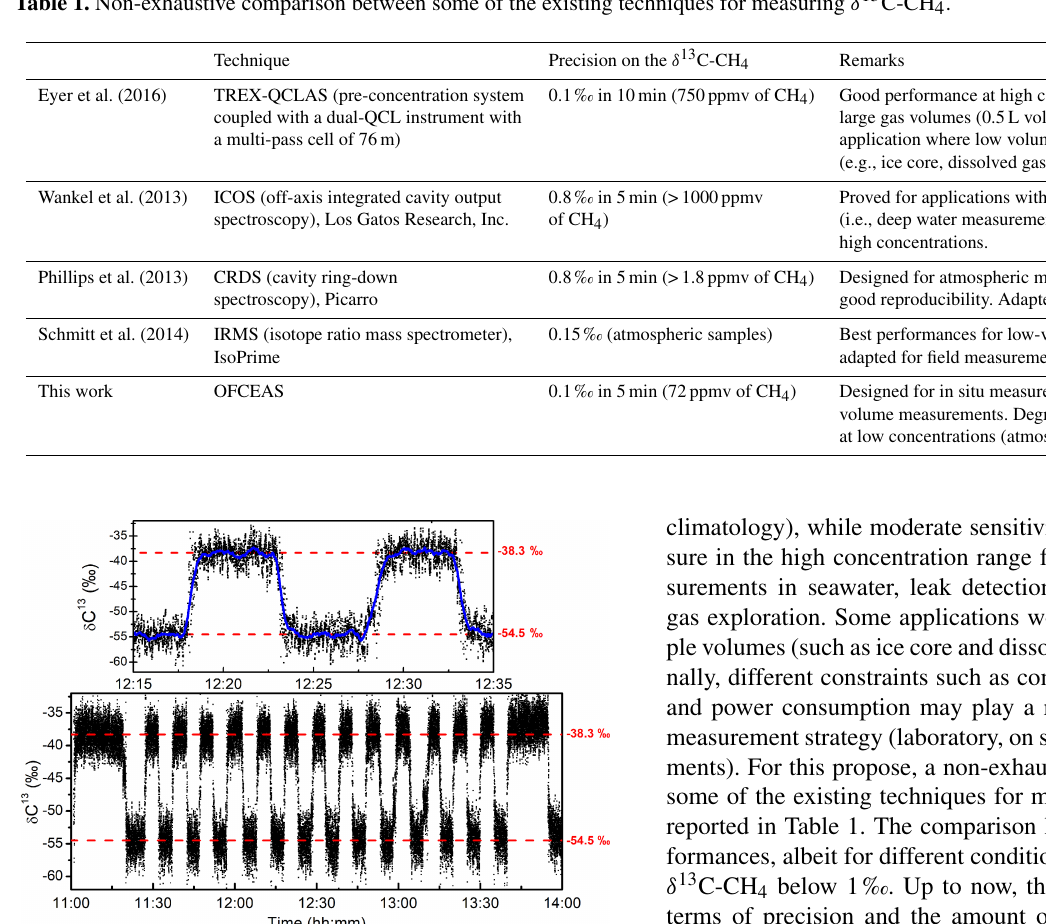
Table 1. Non-exhaustive comparison between some of the existing techniques for measuring δ 13 C-CH 4 .